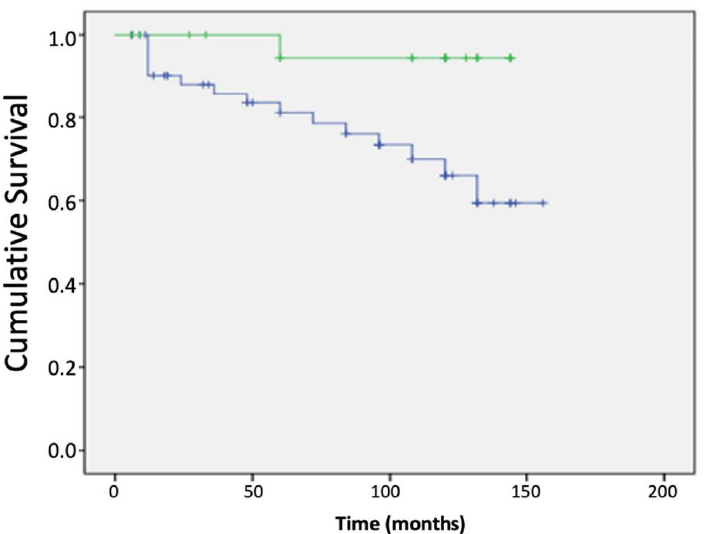
Figure 6. High ALT-PTK6: ptk6 ratio results in favourable overall survival. ptk6 transcript expression was determined in breast cancer tissue (n = 127) in relation to the normal background tissue (n = 33) using real-time qPCR and correlated with conventional clinic-pathological parameters and clinical outcomes. The Kaplan – Meier curves show high ALT-PTK: ptk6 ratios (green) and low ALT-PTK: ptk6 ratios (blue) levels in relation to overall survival. The statistical analysis is shown in the Supplemental Table S5. Table 2. Expression levels of ptk6 , ALT-PTK6, and ptk6 /ALT-PTK6 ratio in relation to hormone re- ceptor status of breast cancer.